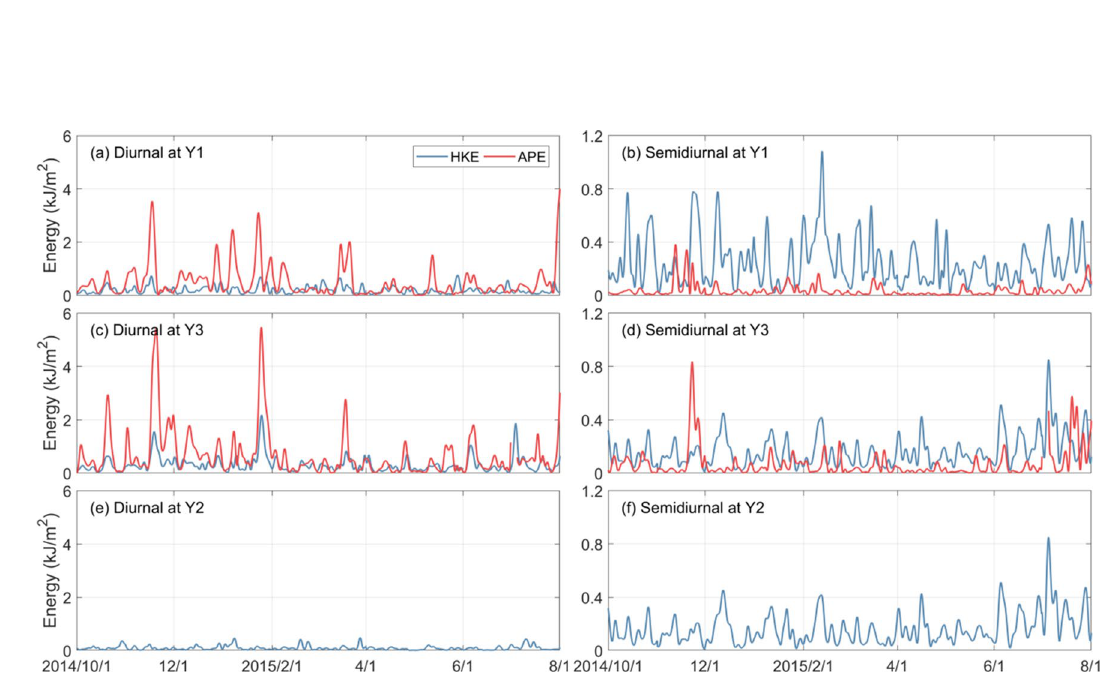
Figure 6. HKE (blue) and APE (red) of the diurnal (left panel) and semidiurnal (right panel) internal waves at moorings ( a and b ) Y1, ( c and d ) Y3 and ( e and f ) Y2. The HKE and APE have been lowpass filtered to eliminate the diurnal and semidiurnal oscillations of the diurnal and semidiurnal internal waves,